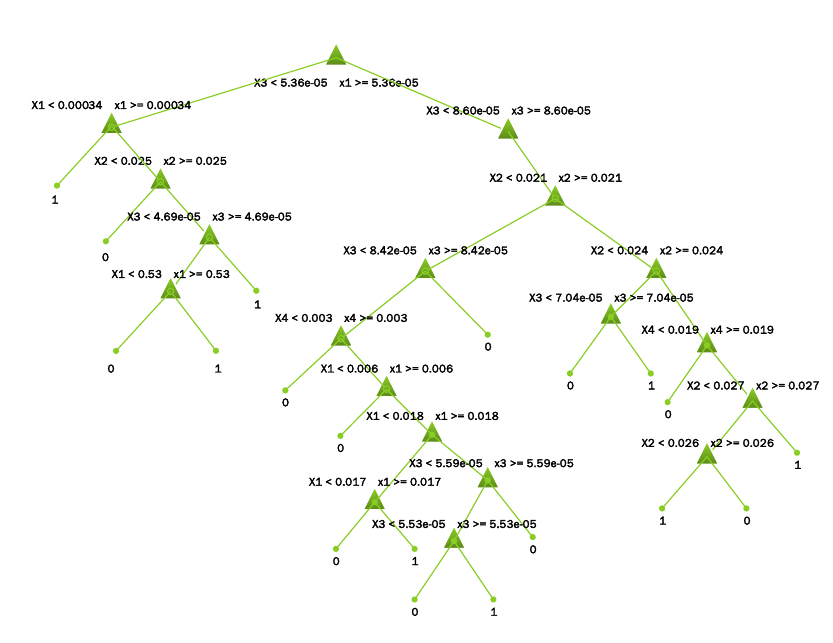
Figure 5. Decision